Question: In one sentence, what is this figure communicating?
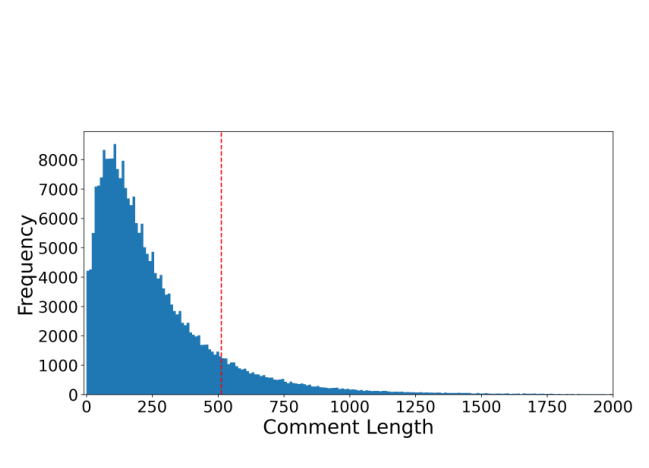
Answer: The histogram of the accumulated comment lengths for each image in AVA-Comments [8]. The vertical dotted line in red indicates a comment length of 512, which is the maximum comment length (Nw) allowed in our experiments.